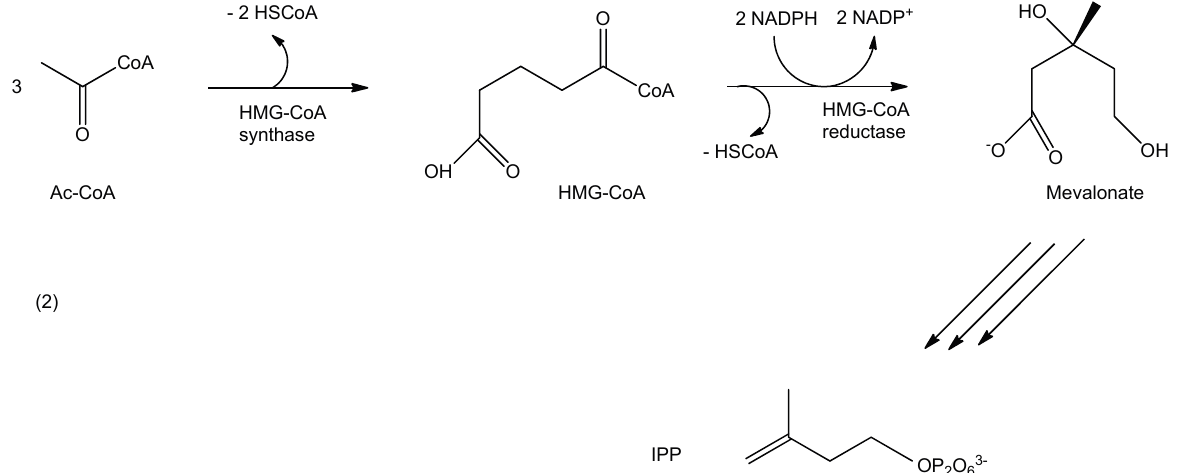
Figure 5. Select steps of the biogeneration of IPP via the mevalonate route in most archaea, fungi and animalia. Three molecules of acetyl-coenzyme A (Ac-CoA) are condensed to hydroxy-3-methylglutaryl-coenzyme A (HMG-CoA) in an HMG-CoA-synthase-catalyzed reaction with a concomitant release of two reduced CoA (HSCoA) molecules. The following endothermic reduction is catalyzed by the HMG-CoA-reductase. Here, reduced CoA is released and Mevalonate is generated, which then, serves as precursor in the biosynthesis of IPP (see text for details).